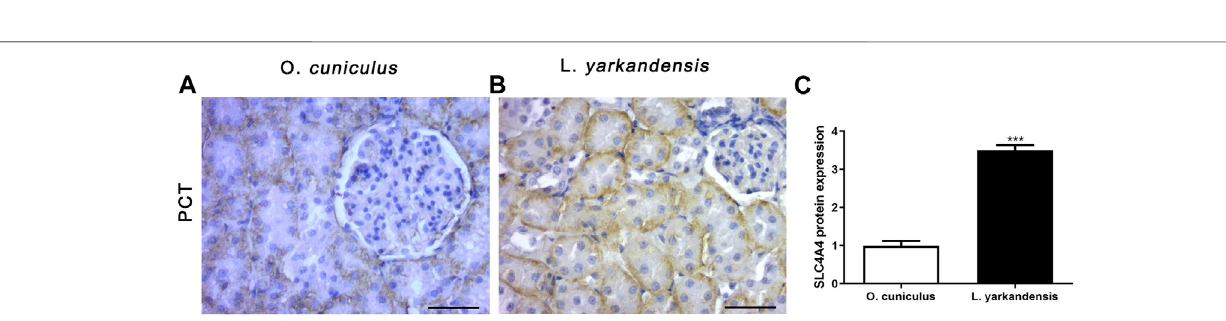
As shown in Figure 7 , the IHC positive signals of ATP1A1 protein are located in the proximal basolateral membrane of the PCT and the thin limbs (TL) of the renal medulla, and the positive staining is light yellow or brown-yellow. Compared with O.